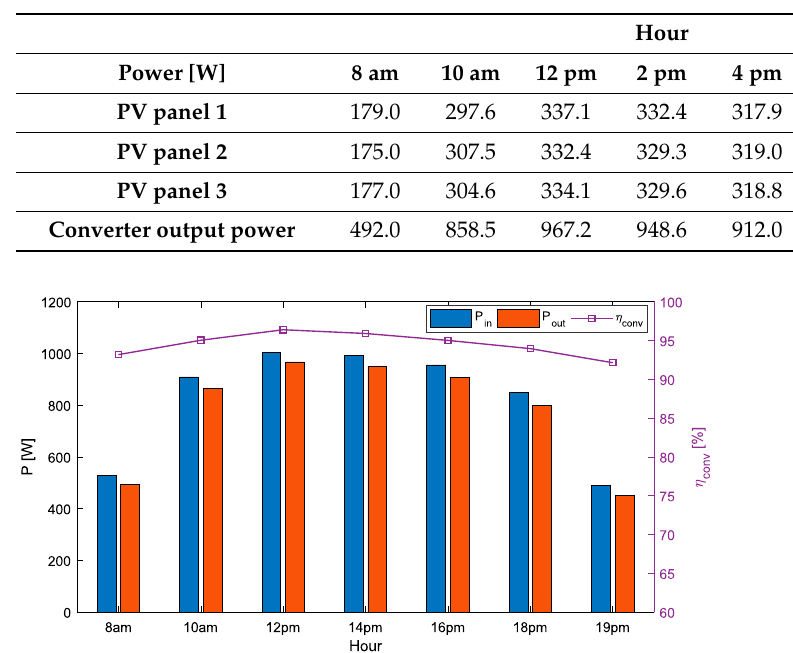
Table 2. Measured power.